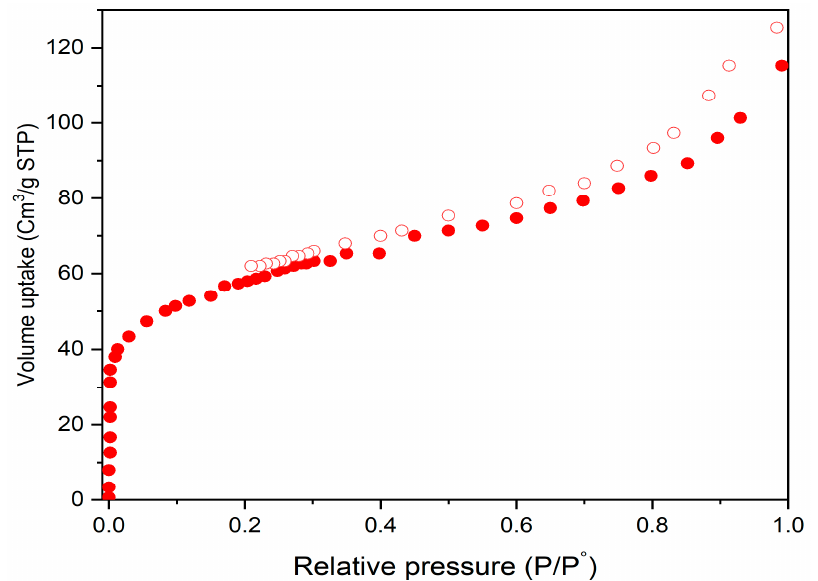
Figure 4. N 2 adsorption − desorption isotherms for the BET surface area of the prepared Bio-MOF (MIP-202).